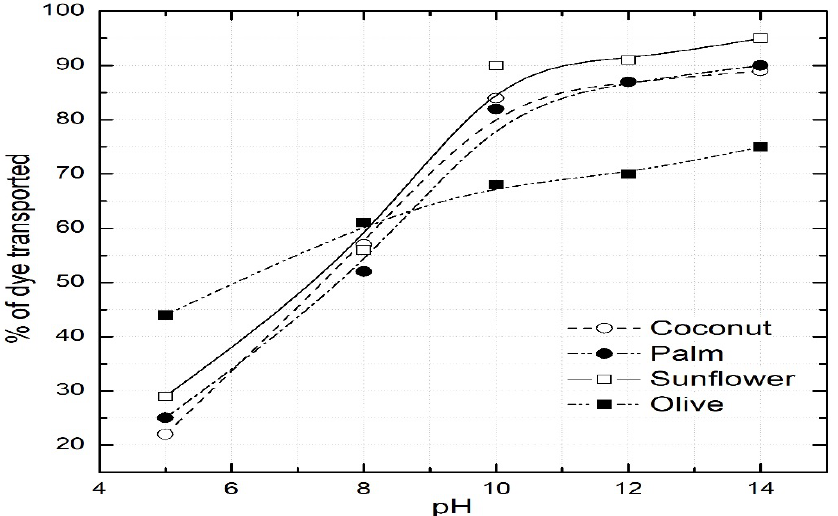
Figure 2. E ff ect of pH in the feed chamber. Dye concentration = 100 mg / L; strip chamber = 0.25 M HCl; permeation time = 14 Figure 2. Effect of pH in the feed chamber. Dye concentration = 100 mg/L; strip chamber = 0.25 M HCl; permeation time = 14 h.